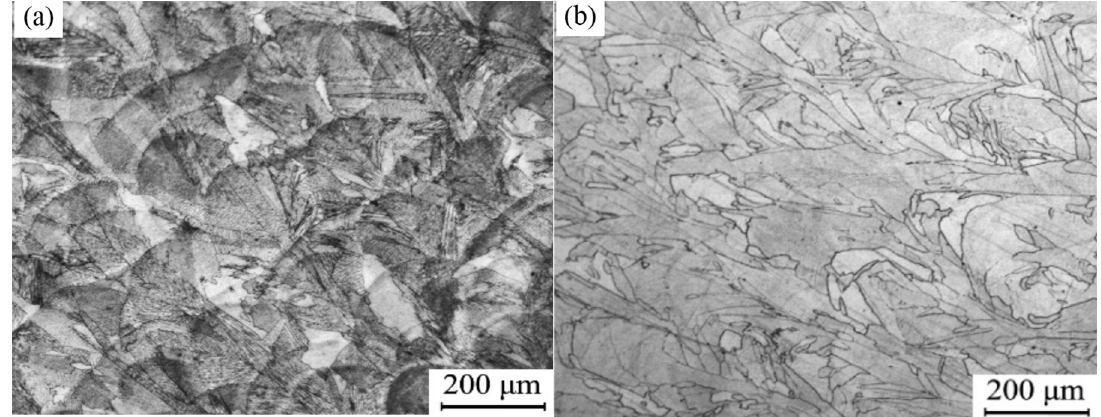
Figure 2. Microstructure in the Z-Y surface of Inconel-718 Ni-based alloys. (a) Microstructure of unheated; (b) Microstructure after heat treatment.